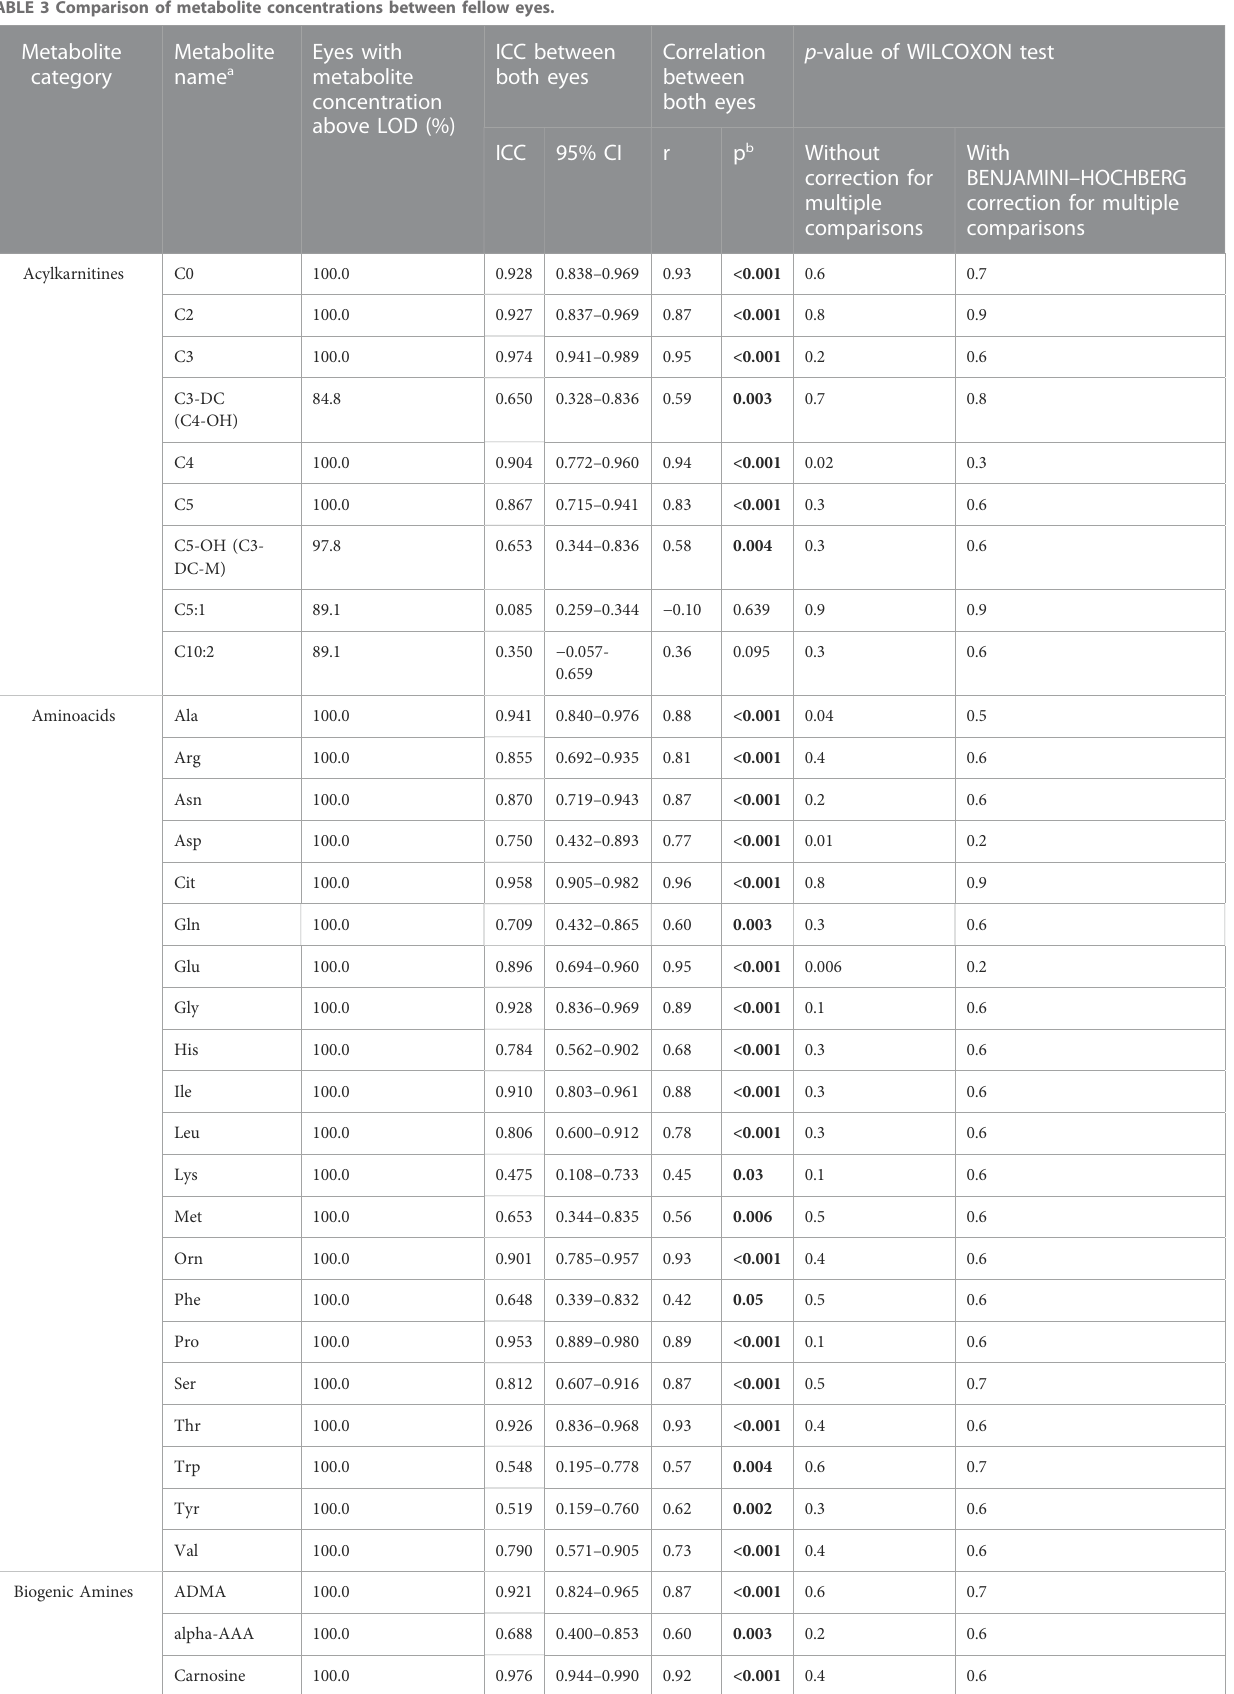
TABLE 3 Comparison of metabolite concentrations between fellow